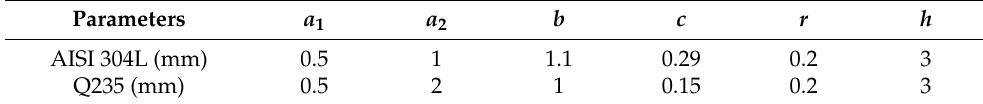
Table 5. The selected parameters for the combined heat source in the simulation.